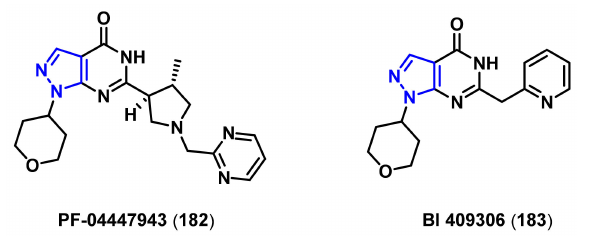
Figure 13. Chemical structures of pyrazole-containing PDE9 inhibitors.